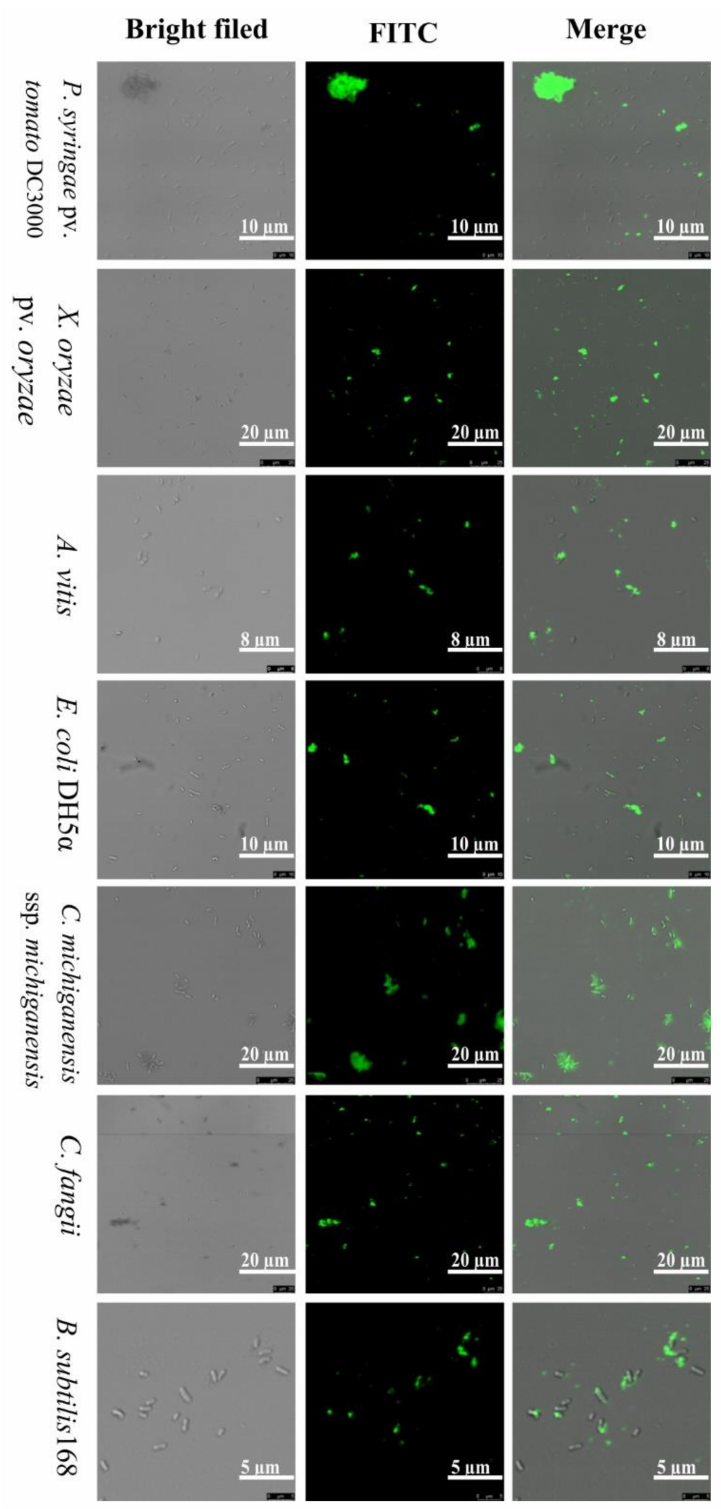
Figure 3. Localization of the FITC-ZM-804 peptide. Bacterial cells were treated with 10 µ M of FITC-labeled ZM-804 peptide for 4 h and visualized under an Olympus BX61 confocal laser scanning microscopy. The localization of the ZM-804 peptide was indicated by the green fluorescence due to the interaction between ZM-804 and the cell membrane of bacterial indicators (Gram-positive and Gram-negative